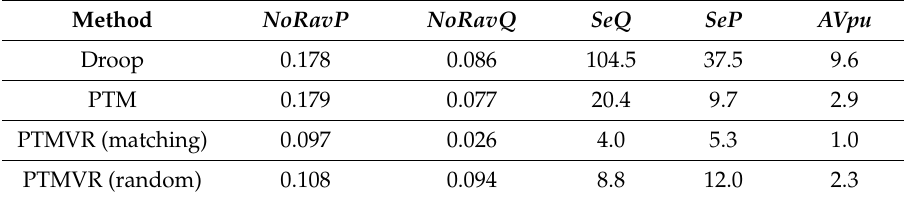
Figure 11. Plot of [ e Q ( t ), e P ( t )] pairs used for the calculation of SeP for droop control. Table 3. Index values for all control methods under